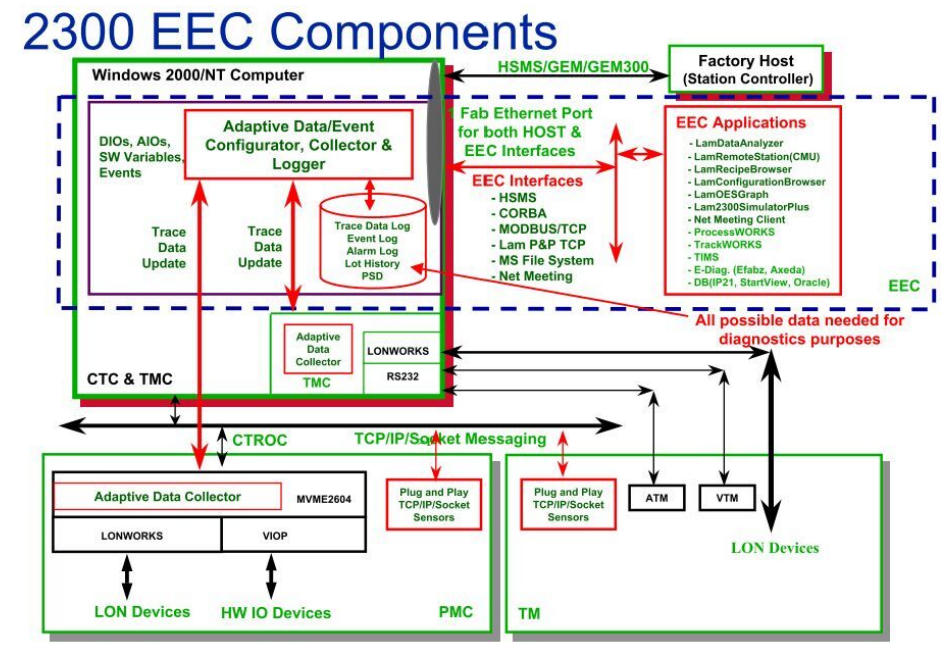
Figure 7. Lam Research simulation